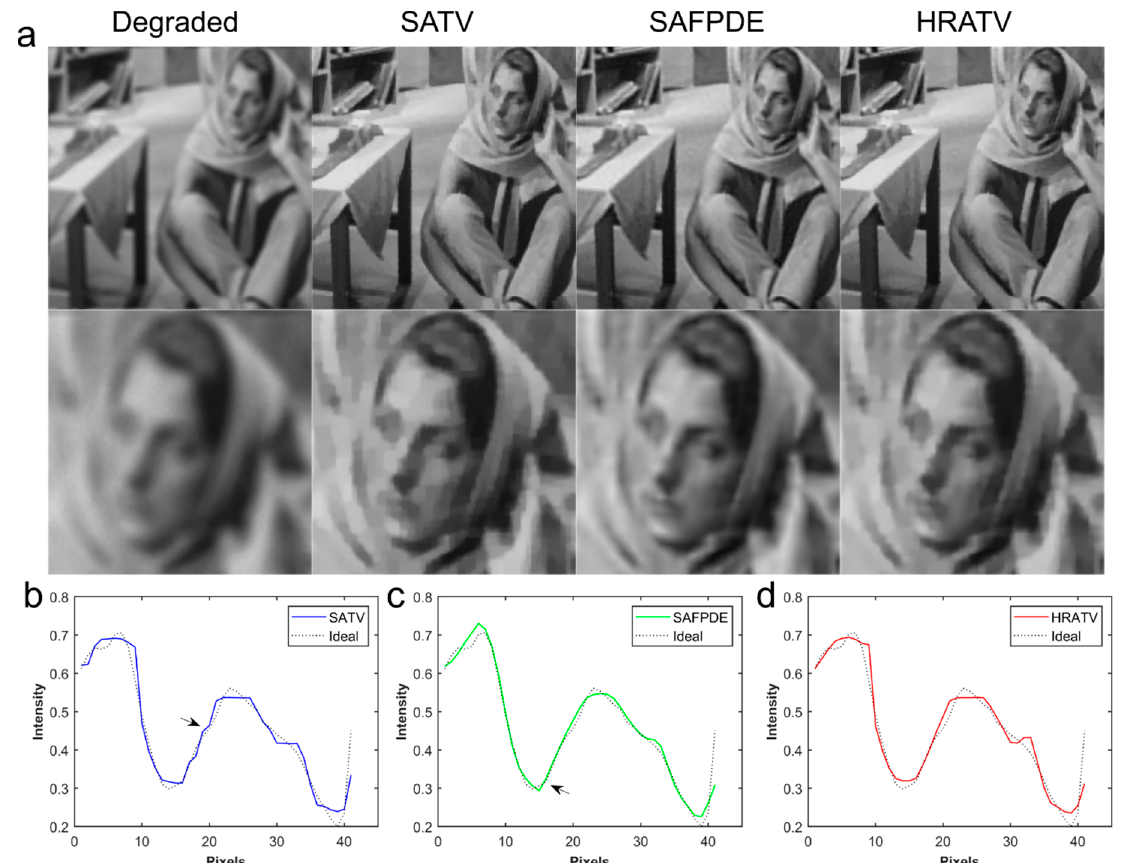
Figure 3. Deconvolution results of image Barbara. ( a ) Degraded image and deconvolution results obtained by Richardson– Lucy blind deconvolution with spatially adaptive total variation (RLBD-SATV), RLBD-spatially adaptive fourth-order partial differential equation (SAFPDE) and RLBD-hybrid reweighted adaptive total variation (HRATV), respectively. ( b – d ) Line profiles along the nose of Barbara.